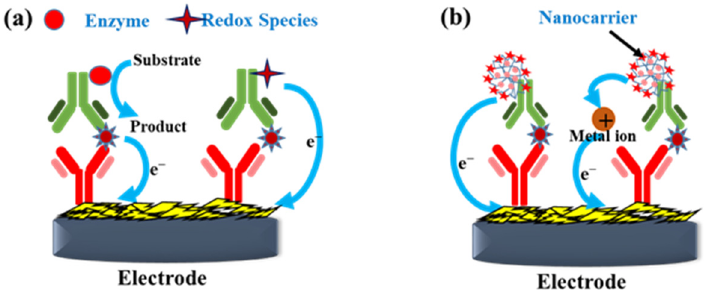
Figure 5. Schemes of the enzyme or redox species-labeled DAb ( a ) and the nanocomposite-based carrier for DAb immobilization ( b ) used in sandwich immunosensors.